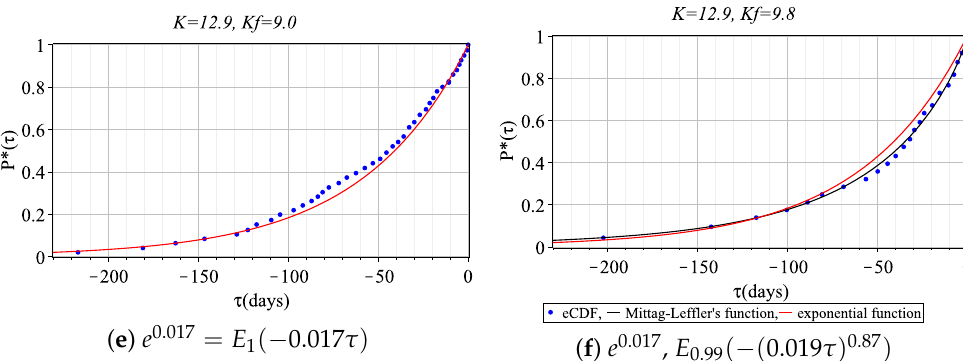
Figure 6. Approximation of the eCDF P ∗ ( τ ) of waiting time of foreshocks (class K f ) for the mainshock (class K ) by the Mittag–Leffler function E ν ( − ( ˜ µτ ) ˜ ν ) (4) and exponential function e µτ